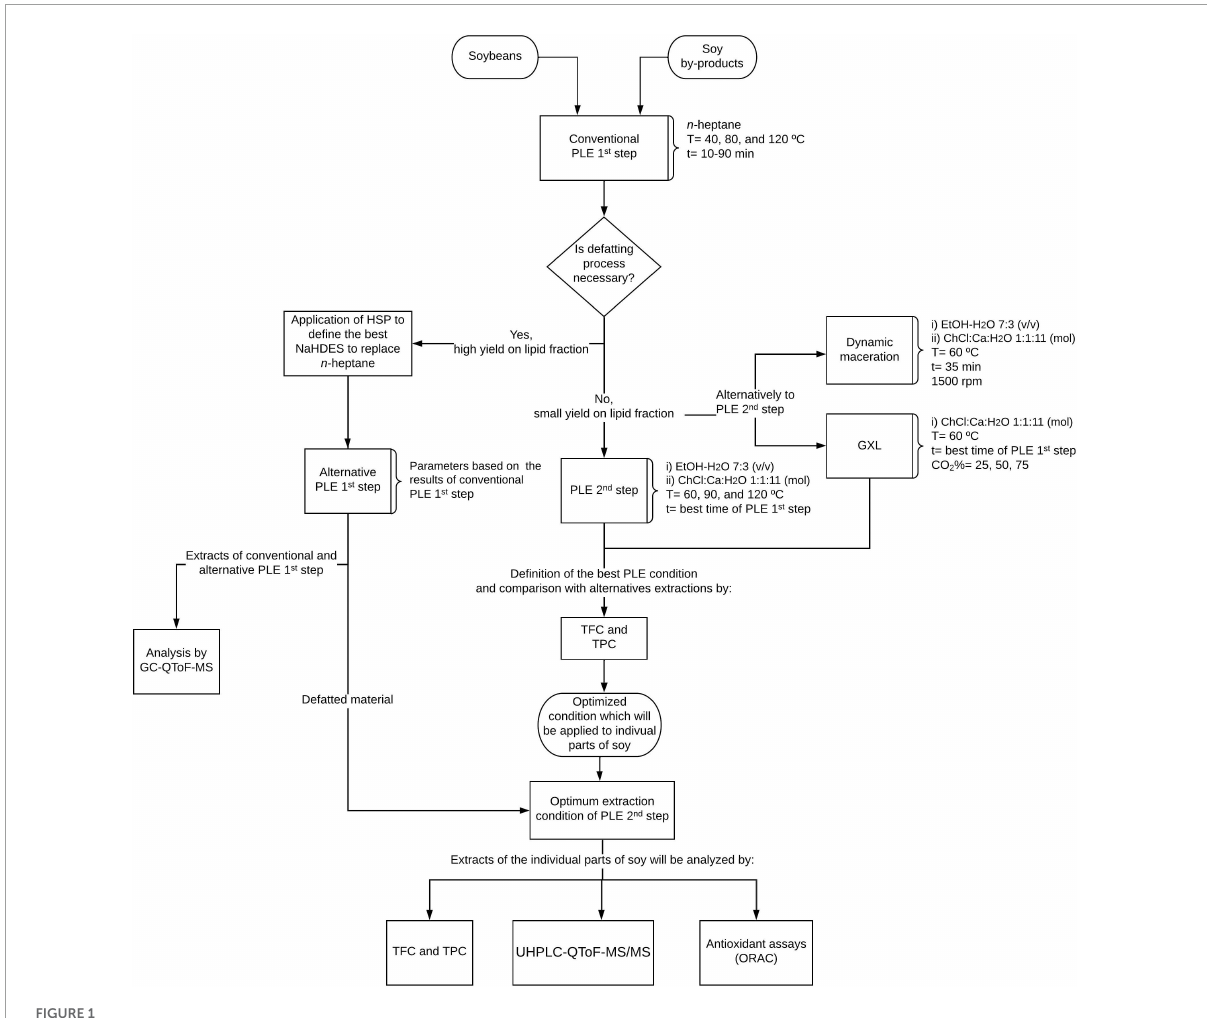
FIGURE1 Flowchart of the extraction procedures and analyses employed in this